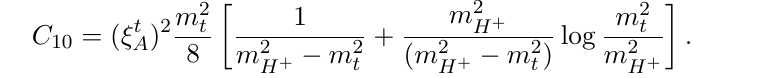
Figure 12 . Correlation between the mass of the charged Higgs m quark, (cid:24) t = (cid:24) t . Green points are allowed by current direct and indirect searches at the LHC. A H + Red and purple shaded regions are excluded at 2 (cid:27) level by measurements of the B ! X s (cid:13) rate under the assumption (cid:16) b = (cid:16) t and of B s ! (cid:22) + (cid:22) (cid:0) transitions,